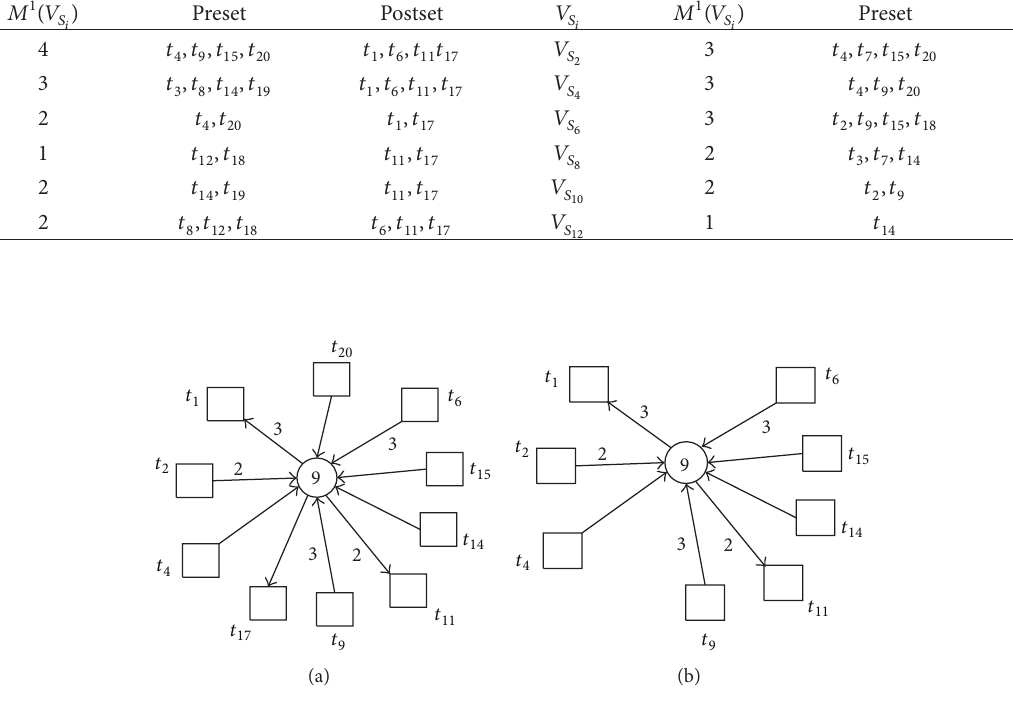
Figure 4: Monitor 𝐸𝑉 𝑆 (a) with original output arcs and (b) with rearranged output 13